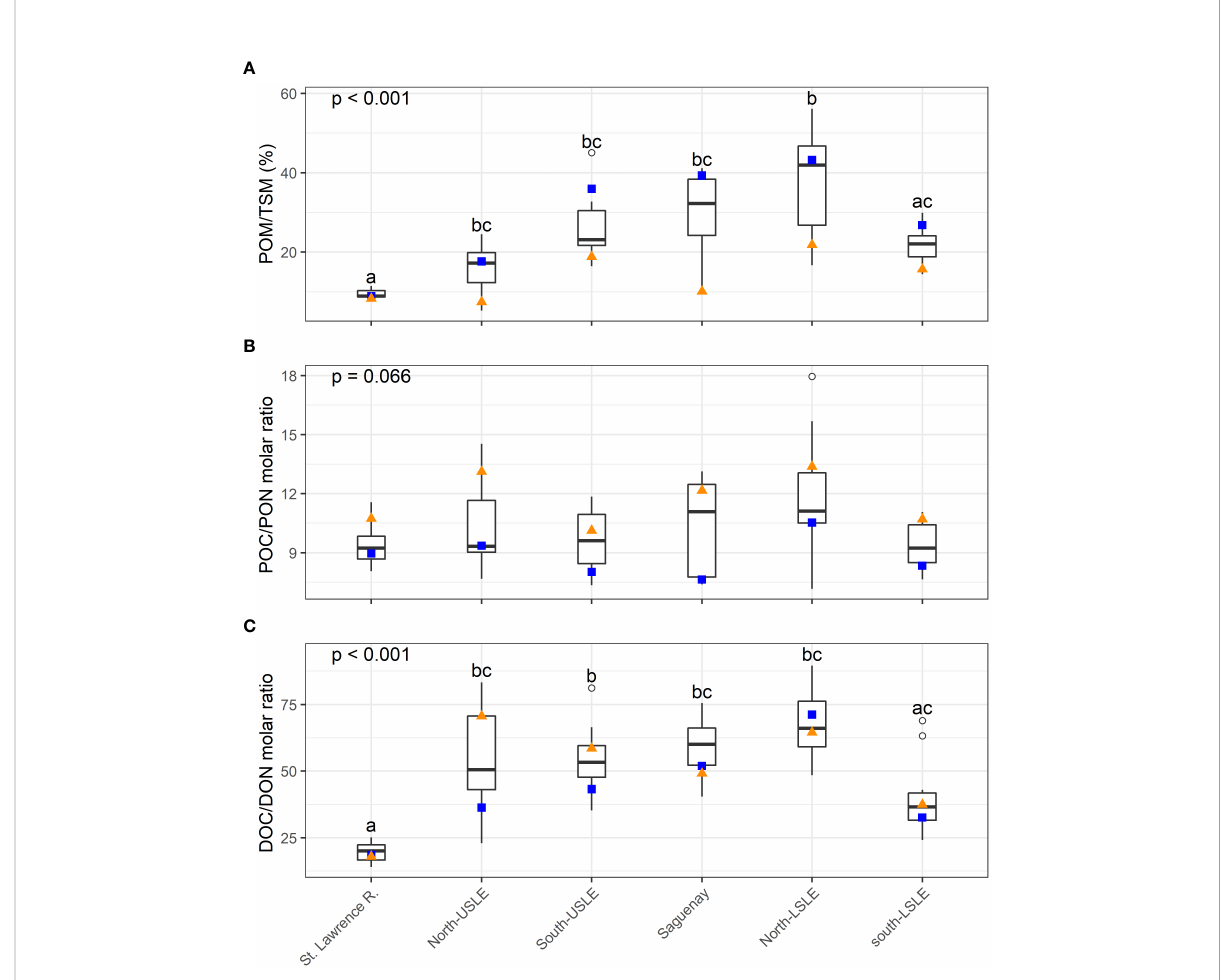
FIGURE 5 Boxplot of (A) POM/TSM (%), (B) POC/PON (molar), (C) DOC/DON (molar) ratios of the St. Lawrence Estuary tributaries. For each box plot, the median is represented by the bolded line while the 25 th and 75 th percentile are represented by the bottom and top of the box, respectively. The whiskers represent the minimum and maximum values (1.5 × interquartile range), and outliers are plotted as circles. Orange triangle = mean value from April to May and blue square = mean value from July to